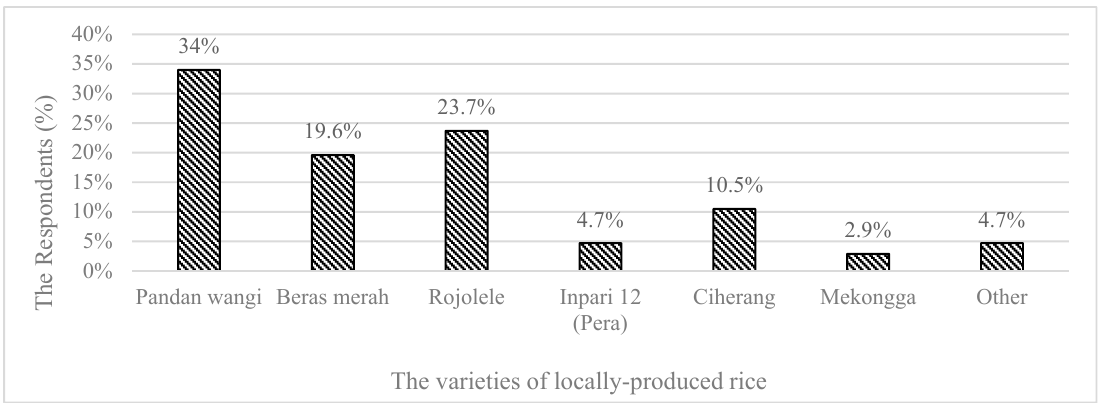
Figure 4. The locally-produced rice varieties in Jakarta Province, Indonesia. Source: Field survey, 2017. The respondents were aware of the locally-produced rice through several means, including friends and/or family members (32.2%), television (23.3%), internet or social media (21.6%), newspapers (11%), and magazines (6.9%), (Figure 5).